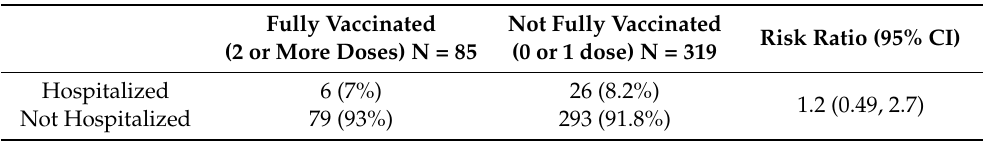
Table 3. Proportion of hospitalization in vaccine-eligible children (>5 years) who are not vaccinated compared to fully vaccinated